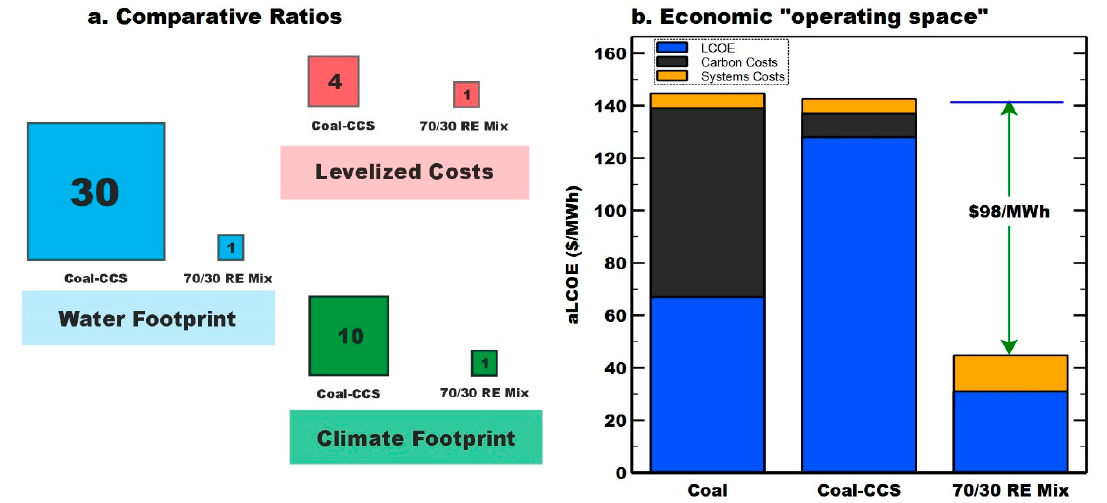
Figure 6. ( a ) Comparative ratios between coal-CCS and a 70/30 solar PV/wind renewable energy mix (RE Mix) for water-climate-cost indicators; ( b ) Economic “operating space” for energy storage technologies by 2030.